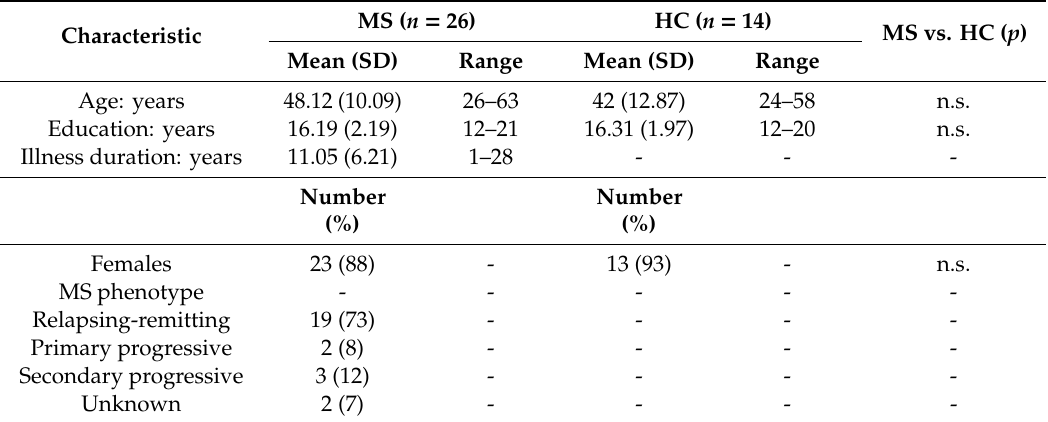
Table 2. Demographic and disease